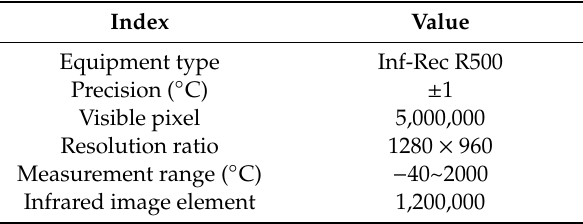
Table 2. Parameters for the thermal infrared camera.